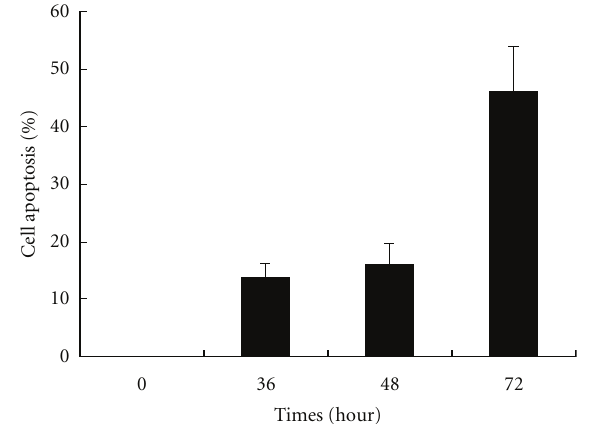
Figure 5: Cell apoptosis of 4 groups of the experimental group 3330 kBq/mL.